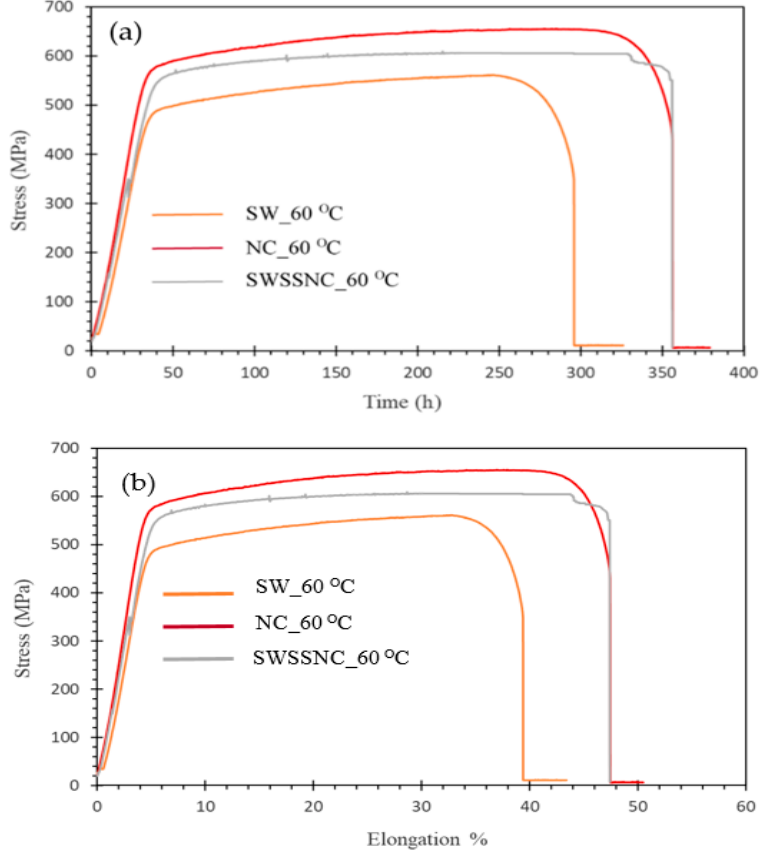
Figure 4. ( a ) Stress vs. time, and ( b ) stress vs. elongation plots of AISI 316 stainless steel alloy at strain rate of 3.7 × 10 − 7 s − 1 in the simulated solutions of SW, NC and SWSSNC at 60 ◦ C.